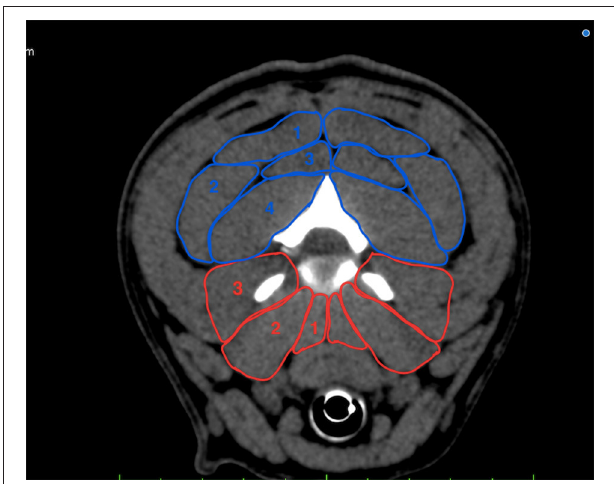
FIGURE 1 | Transverse plane depiction of the paraspinal muscles included in the measurement at the level of C2/C3. Dorsal group (blue): M. biventer cervicis (1), M. longissimus atlantis et capitis (2), M. complexus (3), M. obliquus capitis caudalis (4); ventral group (red): Mm. intertransversarii (3), M. longus capitis (2), M. longus colli (1).